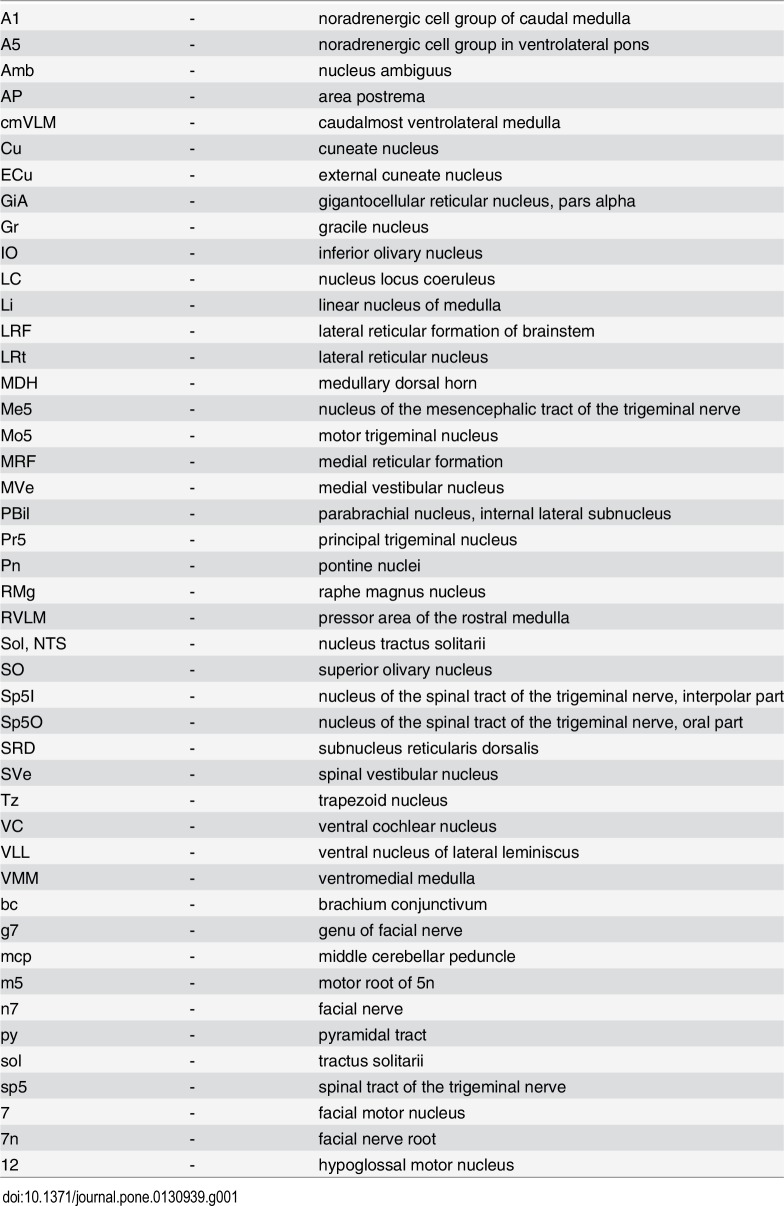
Line drawings illustrating c-Fos activated neurons after a unilateral injection of an algesic solution into the right GCM.Symbols represent a single labeled neuron after injections of buffered normal saline (blue circles), capsaicin (yellow diamonds), low pH acetate buffer (green triangles), and 6% hypertonic saline (red squares). Note the preponderance of immunolabeled neurons in the lateral reticular formation after injections of these algesics into muscle. Also note that immunoreactive neurons in the spinal trigeminal nucleus, parvocellular lateral reticular nucleus and pontine nuclei are not drawn. Numbers to the right of figures represent mm ± 120μm from interaural zero.Abbreviations found on figures:
10.1371/journal.pone.0130939.t001A1-noradrenergic cell group of caudal medullaA5-noradrenergic cell group in ventrolateral ponsAmb-nucleus ambiguusAP-area postremacmVLM-caudalmost ventrolateral medullaCu-cuneate nucleusECu-external cuneate nucleusGiA-gigantocellular reticular nucleus, pars alphaGr-gracile nucleusIO-inferior olivary nucleusLC-nucleus locus coeruleusLi-linear nucleus of medullaLRF-lateral reticular formation of brainstemLRt-lateral reticular nucleusMDH-medullary dorsal hornMe5-nucleus of the mesencephalic tract of the trigeminal nerveMo5-motor trigeminal nucleusMRF-medial reticular formationMVe-medial vestibular nucleusPBil-parabrachial nucleus, internal lateral subnucleusPr5-principal trigeminal nucleusPn-pontine nucleiRMg-raphe magnus nucleusRVLM-pressor area of the rostral medullaSol, NTS-nucleus tractus solitariiSO-superior olivary nucleusSp5I-nucleus of the spinal tract of the trigeminal nerve, interpolar partSp5O-nucleus of the spinal tract of the trigeminal nerve, oral partSRD-subnucleus reticularis dorsalisSVe-spinal vestibular nucleusTz-trapezoid nucleusVC-ventral cochlear nucleusVLL-ventral nucleus of lateral leminiscusVMM-ventromedial medullabc-brachium conjunctivumg7-genu of facial nervemcp-middle cerebellar pedunclem5-motor root of 5nn7-facial nervepy-pyramidal tractsol-tractus solitariisp5-spinal tract of the trigeminal nerve7-facial motor nucleus7n-facial nerve root12-hypoglossal motor nucleus